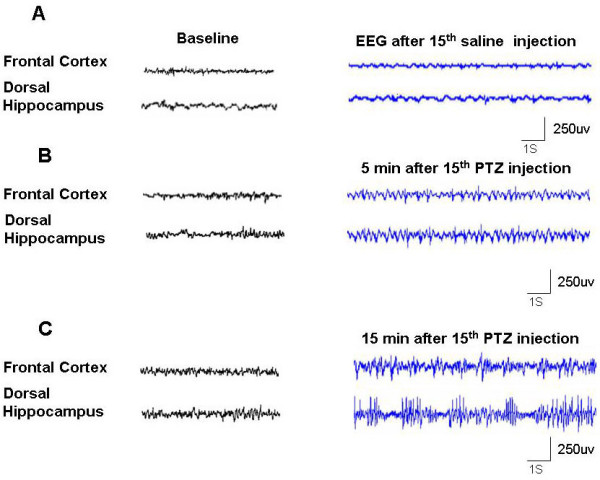
Representative EEG traces in pregnant rat after 15th injections. Representative 30 s EEG samples recorded 5 and 15 min after 15th injection of PTZ (40 mg/kg) during pregnancy at day 16th. A; Showed normal EEG in saline group B; EEG 5 min after 15th PTZ injection and C; EEG 15 min after 15th PTZ injection.